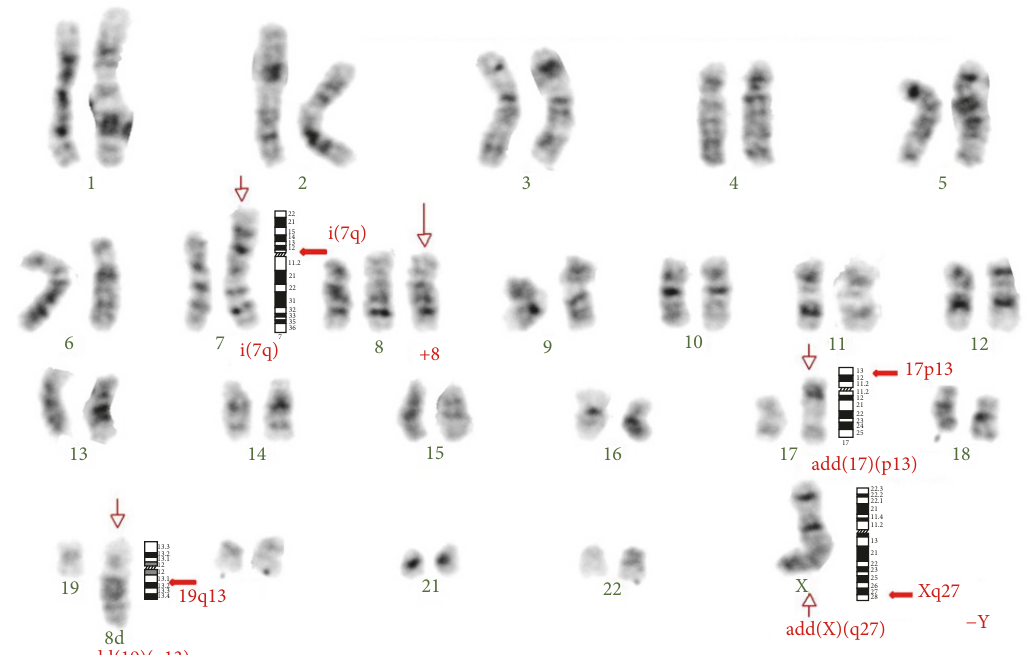
Figure 5: Bone marrow karyotype with chromosome banding analysis with complex aberrancies: 46,add(X)(q27),-Y, i(7)(q10),+8,add(17)(p13),add(19)(q13). Arrows indicate the chromosomal